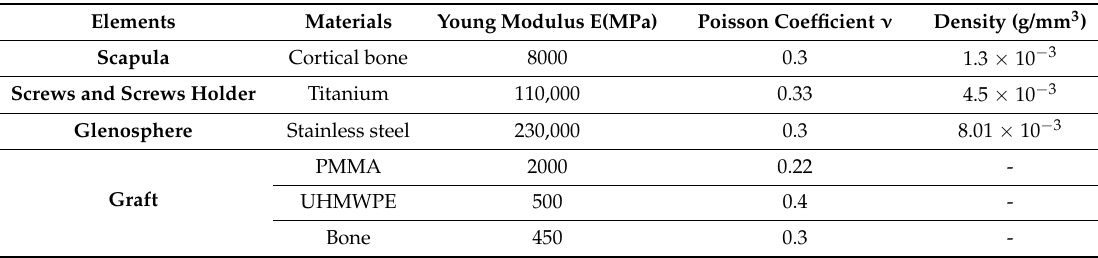
Table 1. Properties of bone and prosthetic materials in shoulder arthroplasty [31,32].